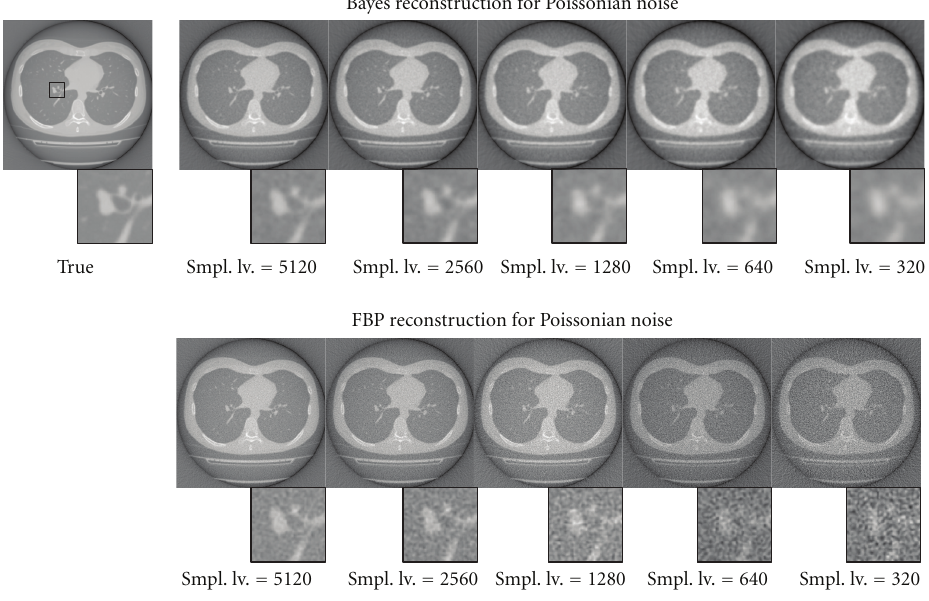
Figure 8: Comparison of the reconstructed images using real CT data with Poissonian noise between Bayes method and conventional FBP method. The top row shows the results of our method, and the bottom one shows the conventional FBP results. Each column corresponds to the strength of the observation noise that can be denoted as the number of sampling in the acceptance-rejection method. We also show the magnification of around bronchus indicated by black rectangle in the true